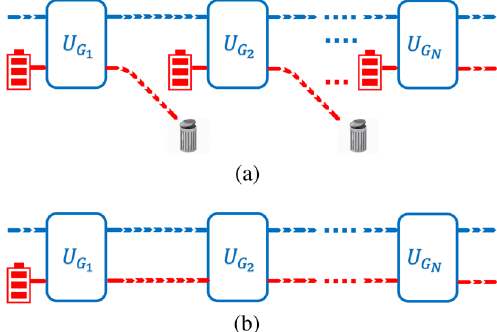
FIG. 2. Multiple and single battery implementations of quan- tum computation. Two different setups of energy-preserving quantum computation are compared. Panel (a) depicts the multiple battery implementation that has often been considered in previous work [12 – 16,19], where each single gate of the circuit is equipped with an individual battery that is discarded after the gate is implemented. In contrast, in this work we consider the single battery implementation as illustrated in (b), where a single battery provides energy for the whole circuit and is reused after the implementation of each individual